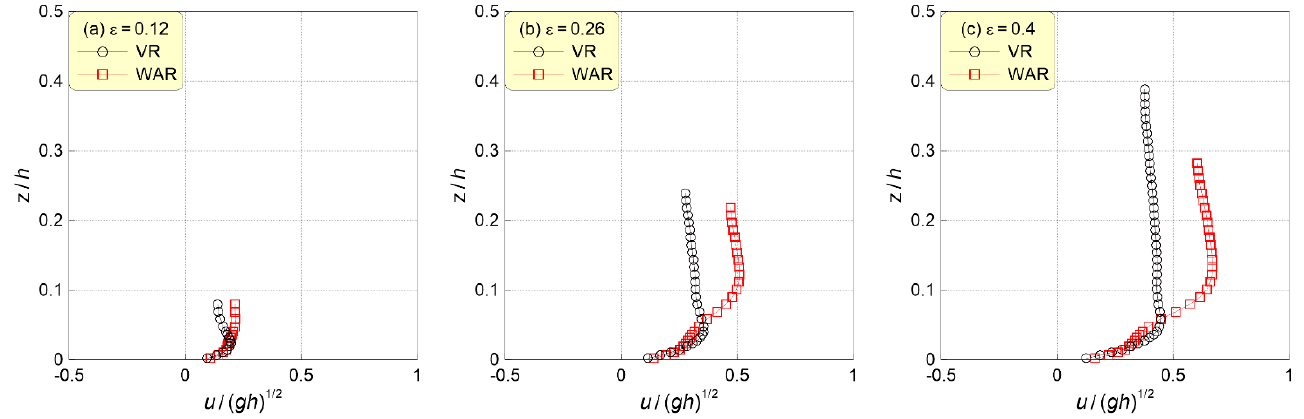
Figure 18. Vertical distribution of horizontal velocity at the front of the vertical wall ( 𝑥/ℎ = 0 ) — comparison between VR and WAR.